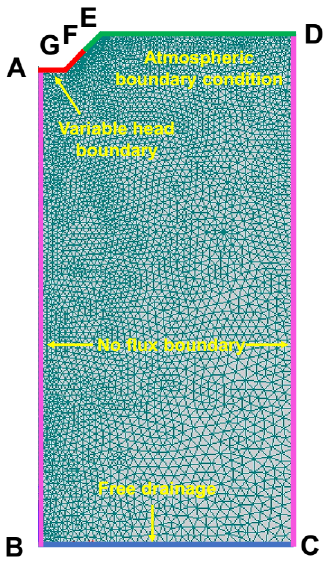
Figure 3. Geometric and boundary conditions of this study. Table 2. Hydraulic properties of sandy loam and